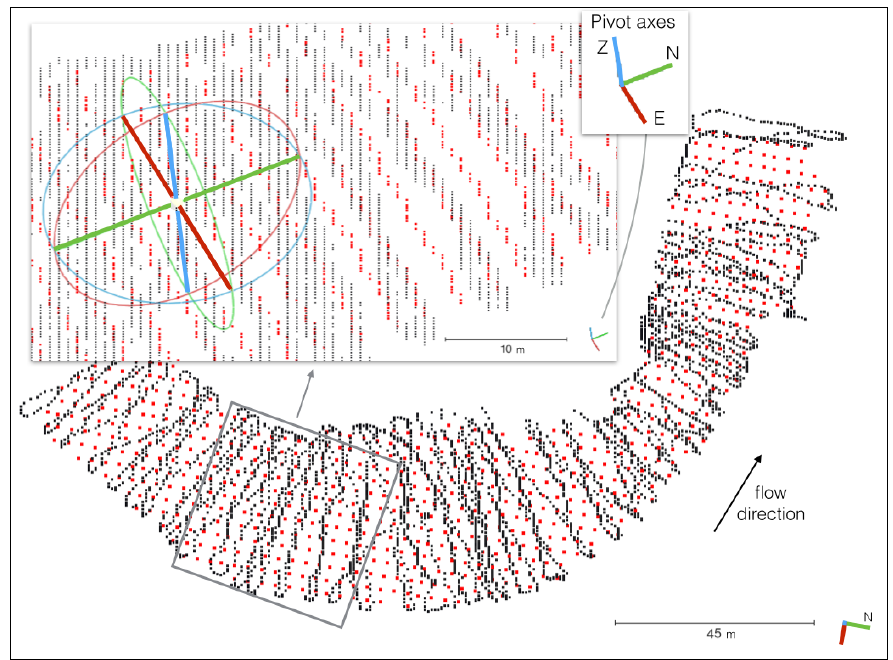
Figure 7. Comparison of original (black) vs. interpolated (red) data example of 19 May in plane